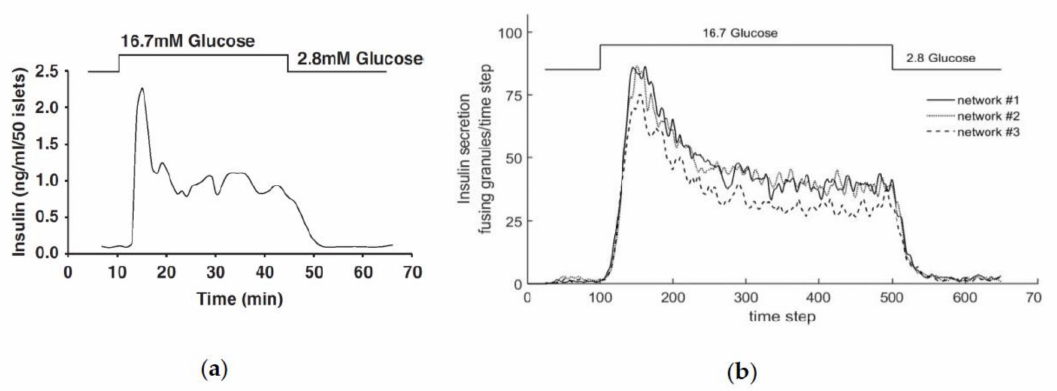
Figure 16. Behavior of insulin secretion at constant excitation with glucose ( a ) measured in an experiment [72], ( b ) simulated with the Cellular